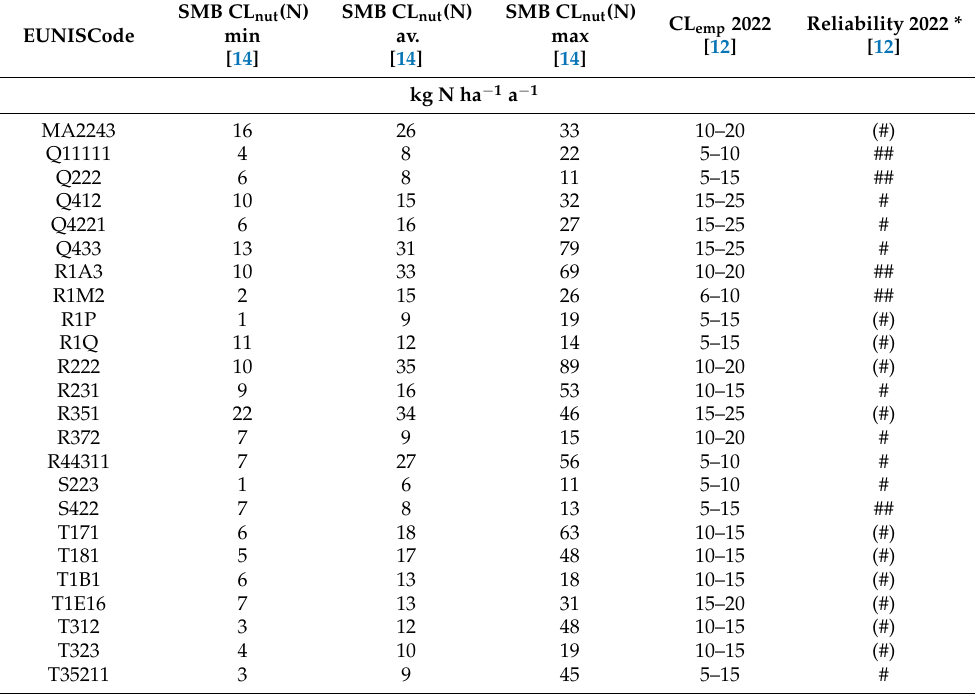
Table 24. Comparison of the CL nut (N)-ranges according to different methods.